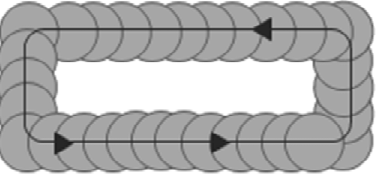
Figure 1. Schematic representation of the laser path during the fabrication of the thin-walled tubes.